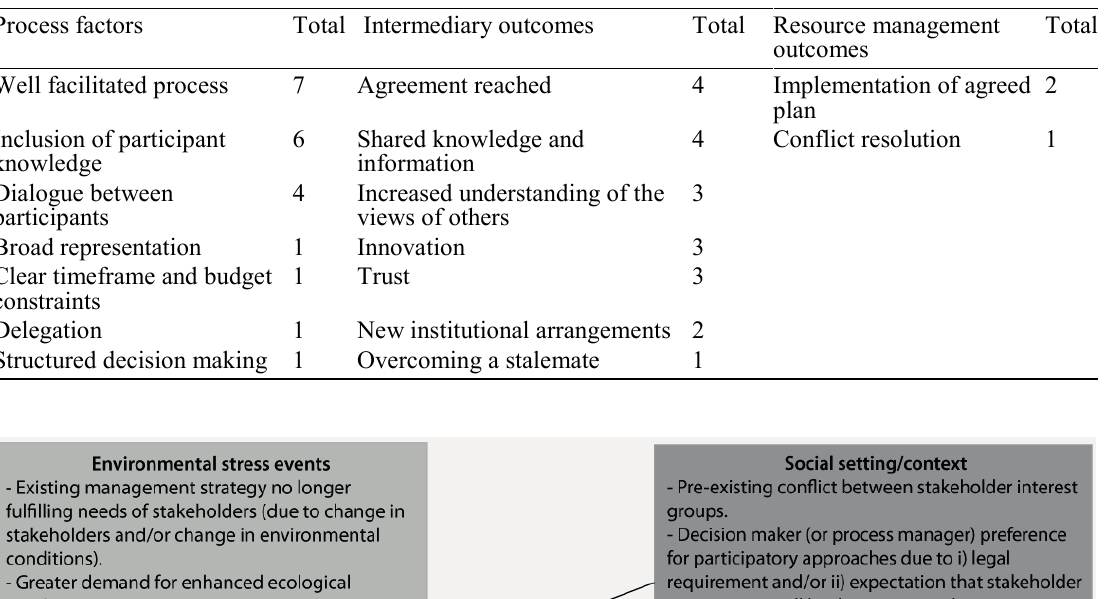
Table 2 Frequency of process factors, intermediary outcomes and resource management outcomes described in the case studies (n = 8).